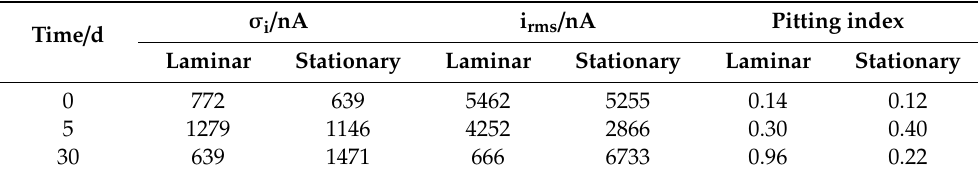
Table 7. Pitting index of AA6061-T6 immersed for 30 days in Caribbean seawater (Cozumel Channel) under laminar and stationary flows.